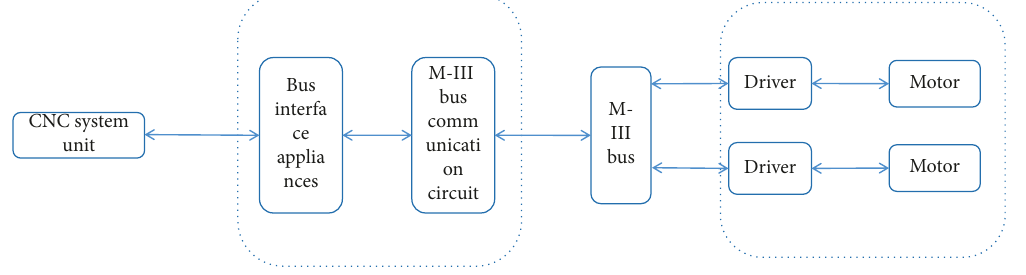
Figure 4: Arc transition coordinate system.